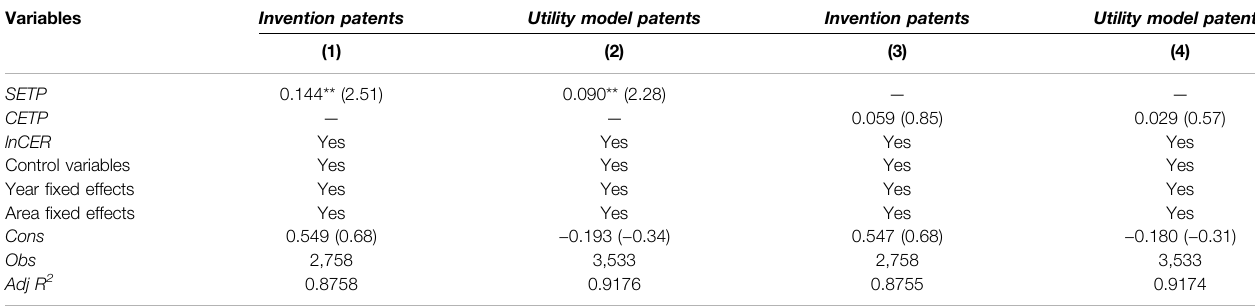
TABLE 6 | Heterogeneity analysis of different types of green innovation patents Variables